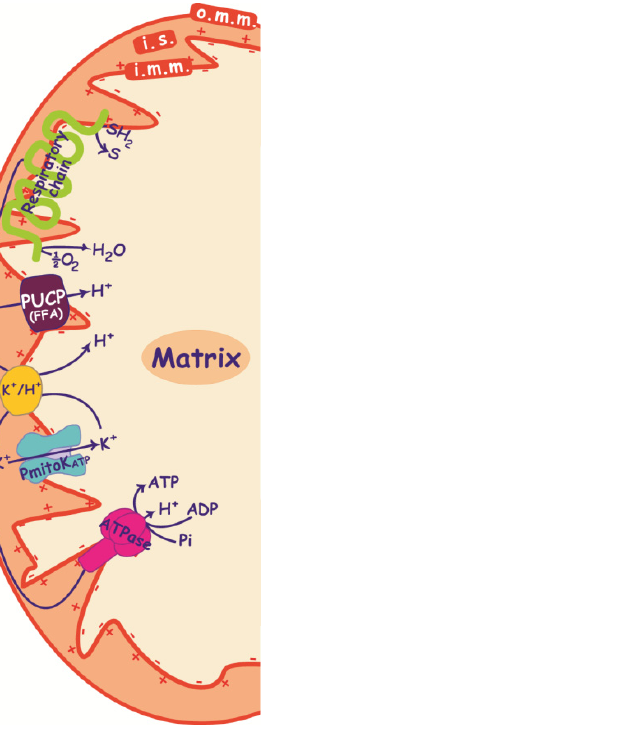
Figure 1. PmitoK and PUCP functioning in DWM. Proton ejection into the ATP intermembrane space by the respiratory chain, which generates a proton electrochemical gradient, is indicated. This proton motive force (pmf) consists of two components: the electrical membrane potential or ∆Ψ (+ and − signs in the figure), which is the main component of pmf in plant mitochondria, and the proton gradient or ∆ pH, which is even negligible in DWM. The proton re-entry into the matrix via the ATPase drives the ATP catalyses the electrophoretic K + uptake across the inner membrane synthesis. PmitoK ATP towards the matrix; when K + uptake via PmitoK is associated with a K + efflux through ATP the K + /H + antiporter, a very active K + cycle is generated, that allows proton re-entry into the matrix. PUCP mediates proton re-entry into the matrix in the presence of free fatty , reduced substrates; S, oxidized substrates; i.m.m., inner acids (FFAs). SH 2